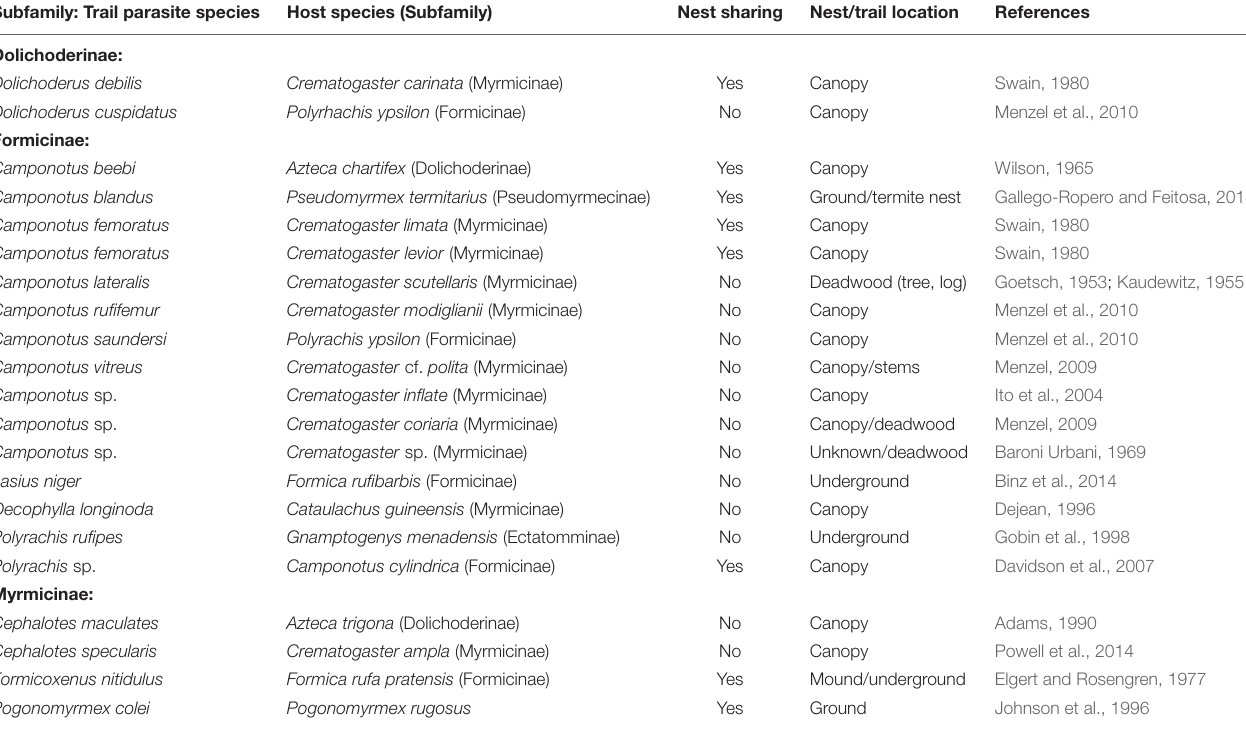
TABLE 2 | Eavesdropping ant species using trail pheromones of distantly related ant